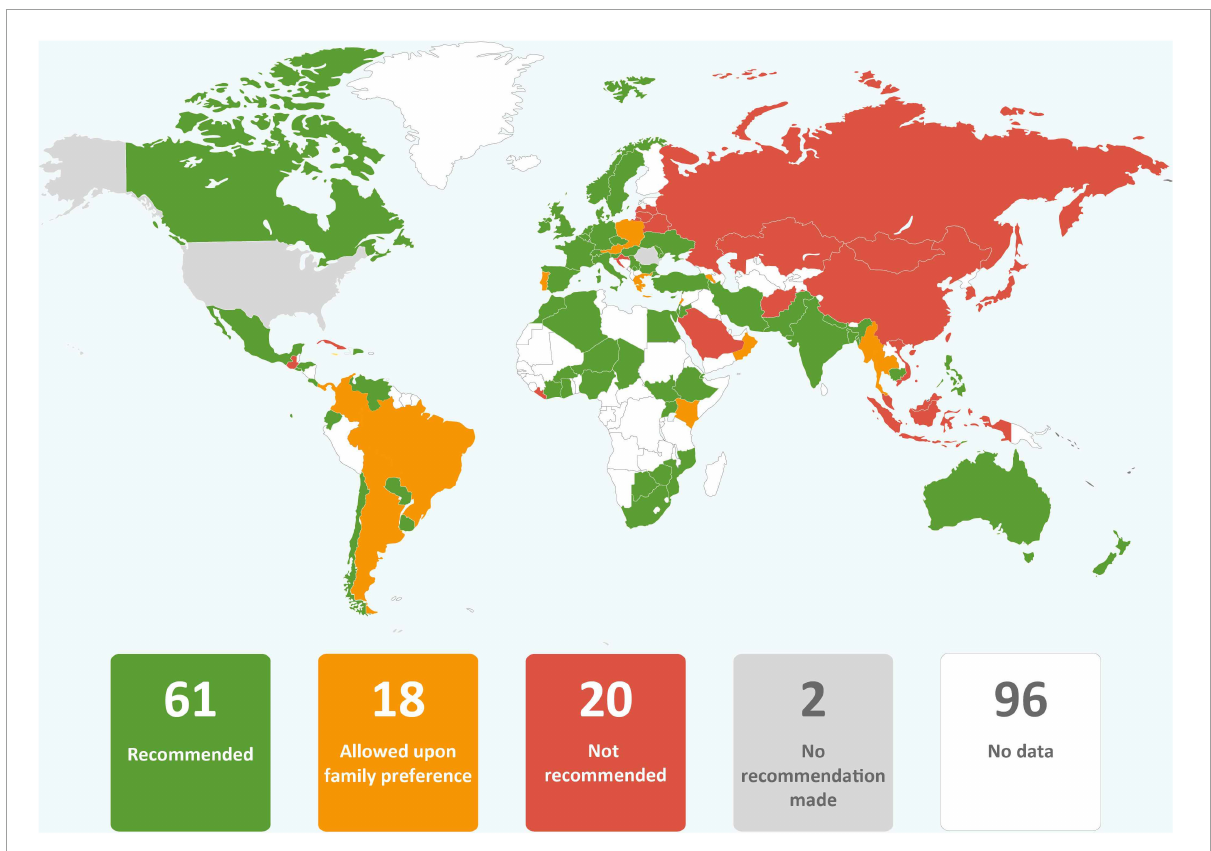
FIGURE4 Global distribution of recommendations on direct breastfeeding for infants of mothers with COVID-19 (data from 101